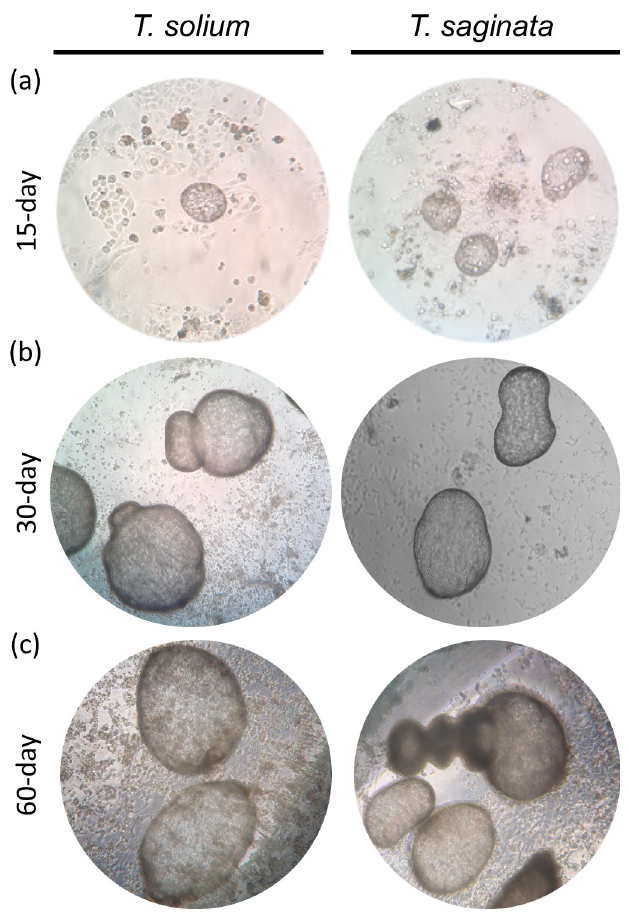
Fig 1. Light microscopy of postoncospheral form of T . solium and T . saginata displaying parasite morphology at different times of development in INT-407 culture. T . solium and T . saginata at 15-day PO form (a) 30-day PO form (b) and at 60-day PO form (c) Magnification